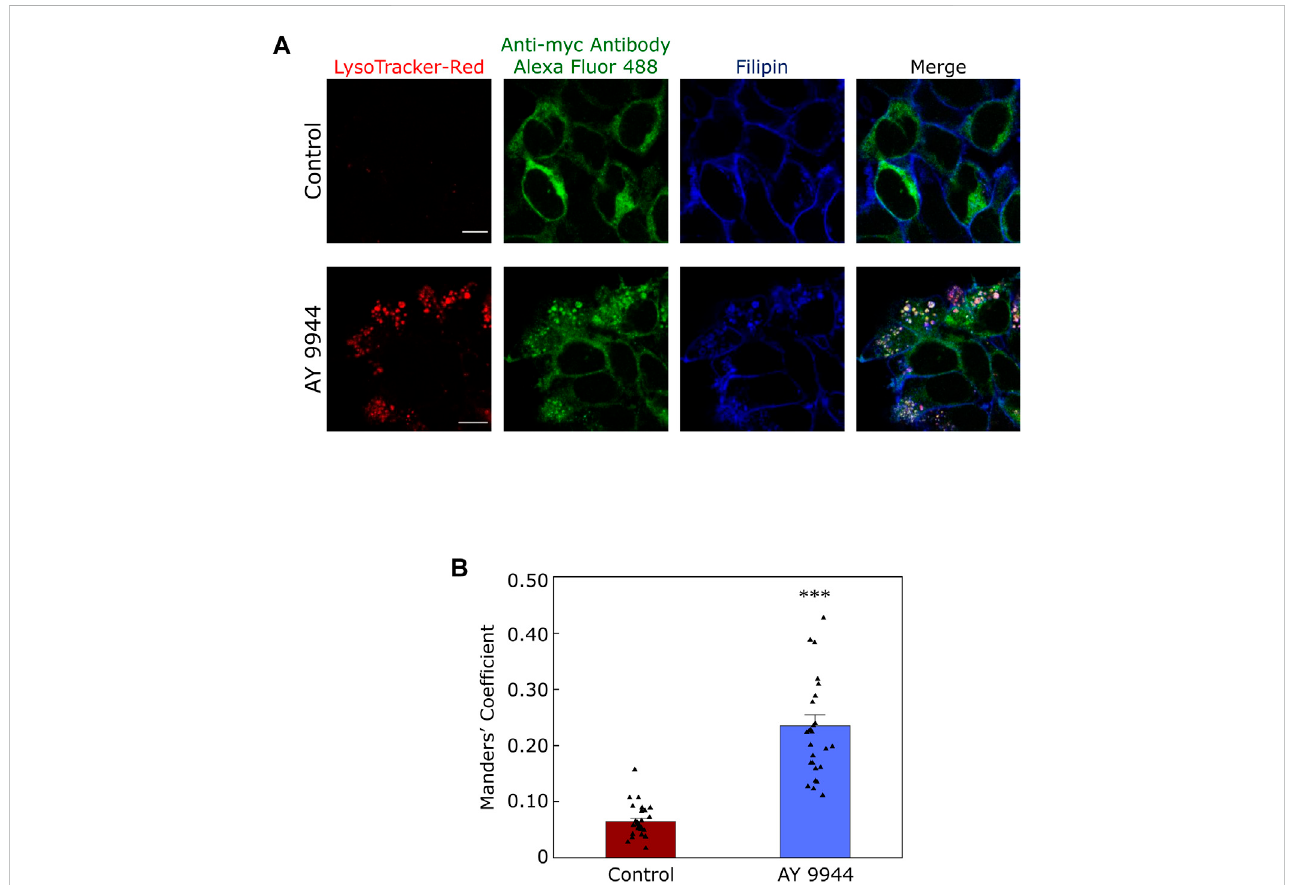
FIGURE 5 Defective traf fi cking of a neurotransmitter receptor in a cellular model of SLOS. Serotonin 1A receptors are predominantly localized in the plasma membrane in HEK-293 cells stably expressing human serotonin 1A receptors myc-tagged at the N-terminal (HEK-5-HT 1A R cells). We generated a cellular modelofSLOSbychronictreatmentofHEK-5-HT 1A RcellswithAY9944,aspeci fi cinhibitorof7-DHCR,theenzymethatconverts7-DHCtocholesterolinthe last step of the Kandutsch-Russell pathway of cholesterol biosynthesis (see Figures 1, 4). Our results show a considerable reduction in the plasma membrane population of the serotonin 1A receptor in SLOS-mimicking condition. In addition, we observed accumulation of sterol-enriched LysoTracker positive compartments in these conditions (see LysoTracker-Red mid plane sections in control and AY 9944 treated conditions). The loss in plasma membrane localization was accompanied by an increased localization of the serotonin 1A receptor in sterol-enriched LysoTracker positive compartments, indicating that there isalteredtraf fi cking of serotonin 1A receptors in SLOS-like condition. (A) The panel shows representative confocal microscopic imagesof the mid-plane section showing the extent of colocalization between LysoTracker-Red (red), the serotonin 1A receptor (green) and fi lipin (blue) in control (untreated) conditions and those treated with AY 9944 [the extent of colocalization is shown by Manders ’ colocalization coef fi cient, see panel (B) ]. Scale bars represent 10 μ m. Serotonin 1A receptors were tagged with anti-myc antibody Alexa Fluor 488 conjugate. Filipin is a polyene antibiotic which labels free (unesteri fi ed)sterols.Lateendosomal/lysosomalcompartmentswerelabeledwithLysoTracker-Red. (B) Quantitativeestimatesoftheextentofcolocalization of the serotonin 1A receptor with LysoTracker-Red in control (maroon) and AY 9944 treated cells (blue) expressed as Manders ’ coef fi cient. The concentration of AY 9944 was 2 μ M in all cases. Adapted and modi fi ed with permission from Sharma et al., 2021. See text for more